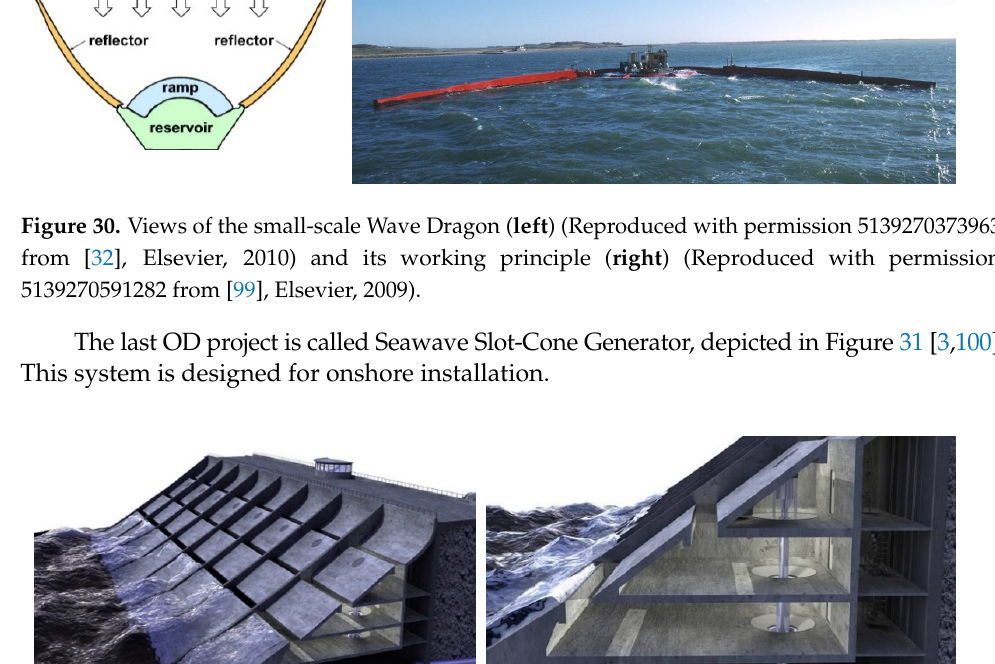
Figure 31. External view ( left ) [3] and section view ( right ) [100] of Slot-Cone. In detail, the system is composed of three chambers, located at different heights. Each chamber has an opening, located at the superior point. The system has an external ramp- like shape, to increase the water height and fill the internal chambers. A multistage low- head hydro turbine is used to transform the potential energy of water inside each chamber into electricity. Two pilot plants have been planned for the realization along the west Norwegian coasts, but have not been realized [100]. Finally, OIST Wave-Energy Project can be included in this category. The idea is the conveying of breaking waves inside a duct, to run a low-head hydro turbine. A schematic is reported in Figure 32 [101]. The first test was realized in 2016. After that, 2 half-scale devices (turbine 35 cm wide and rated power of 1.3 kW) were installed and tested at the eastside beach of Kandooma Island in the Maldives in May 2018, accumulating over 7200 h in just ten months (February 2019). Another two full-scale WECs (60 cm turbine, 8 kW peak) were installed in November 2018 (operating over 2000 h in just three months) [101]. The following Table 5 summarizes the main specifics of the current technologies for sea wave harvesting, based on the OD principle. Table 5. Summary of the main OD devices. Project